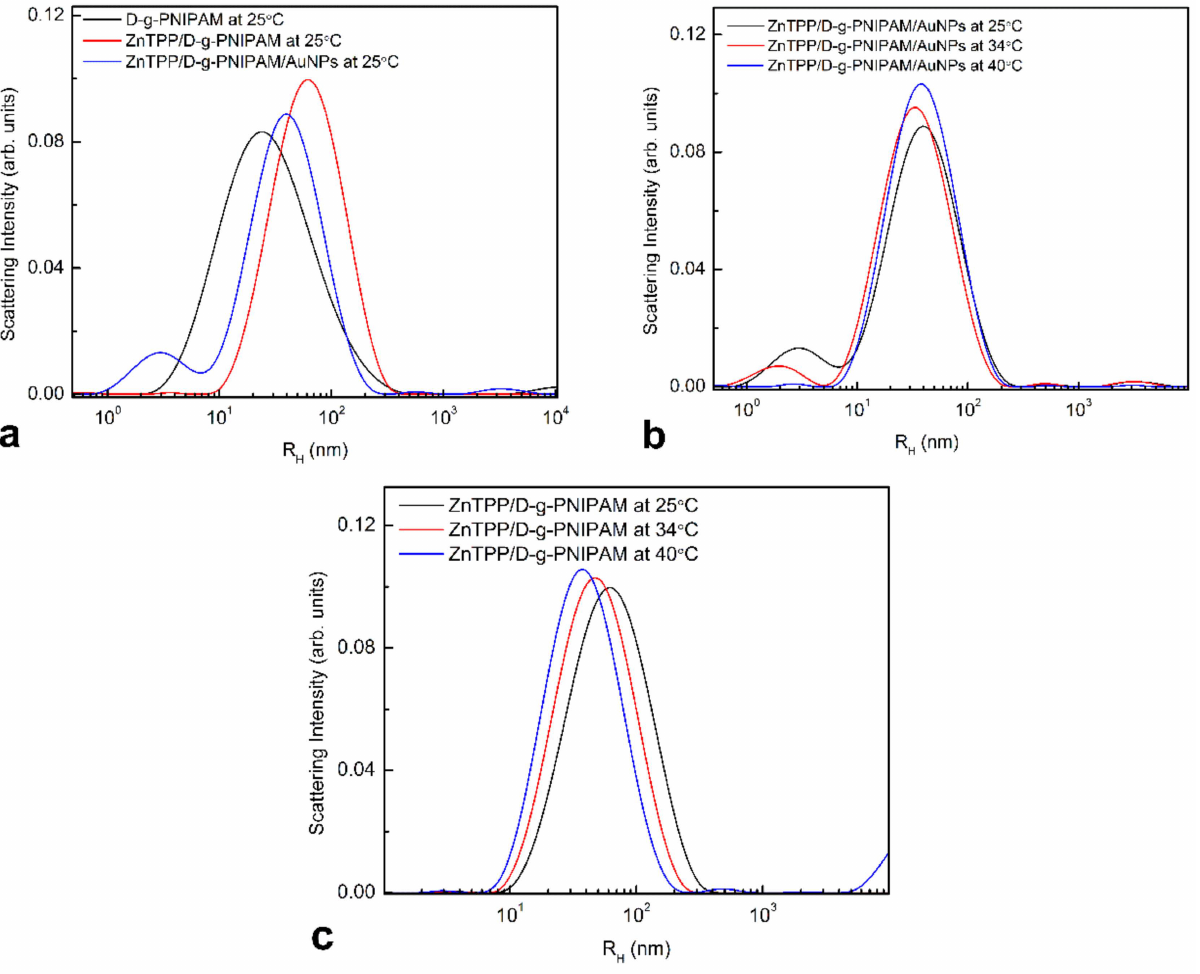
Figure 4. PSD of different solutions at 25 ◦ C for comparison ( a ); triple system of ZnTPP/D-g- PNIPAM/AuNPs at 25, 34 and 40 ◦ C ( b ); ZnTPP/D-g-PNIPAM at 25, 34 and 40 ◦ C ( c